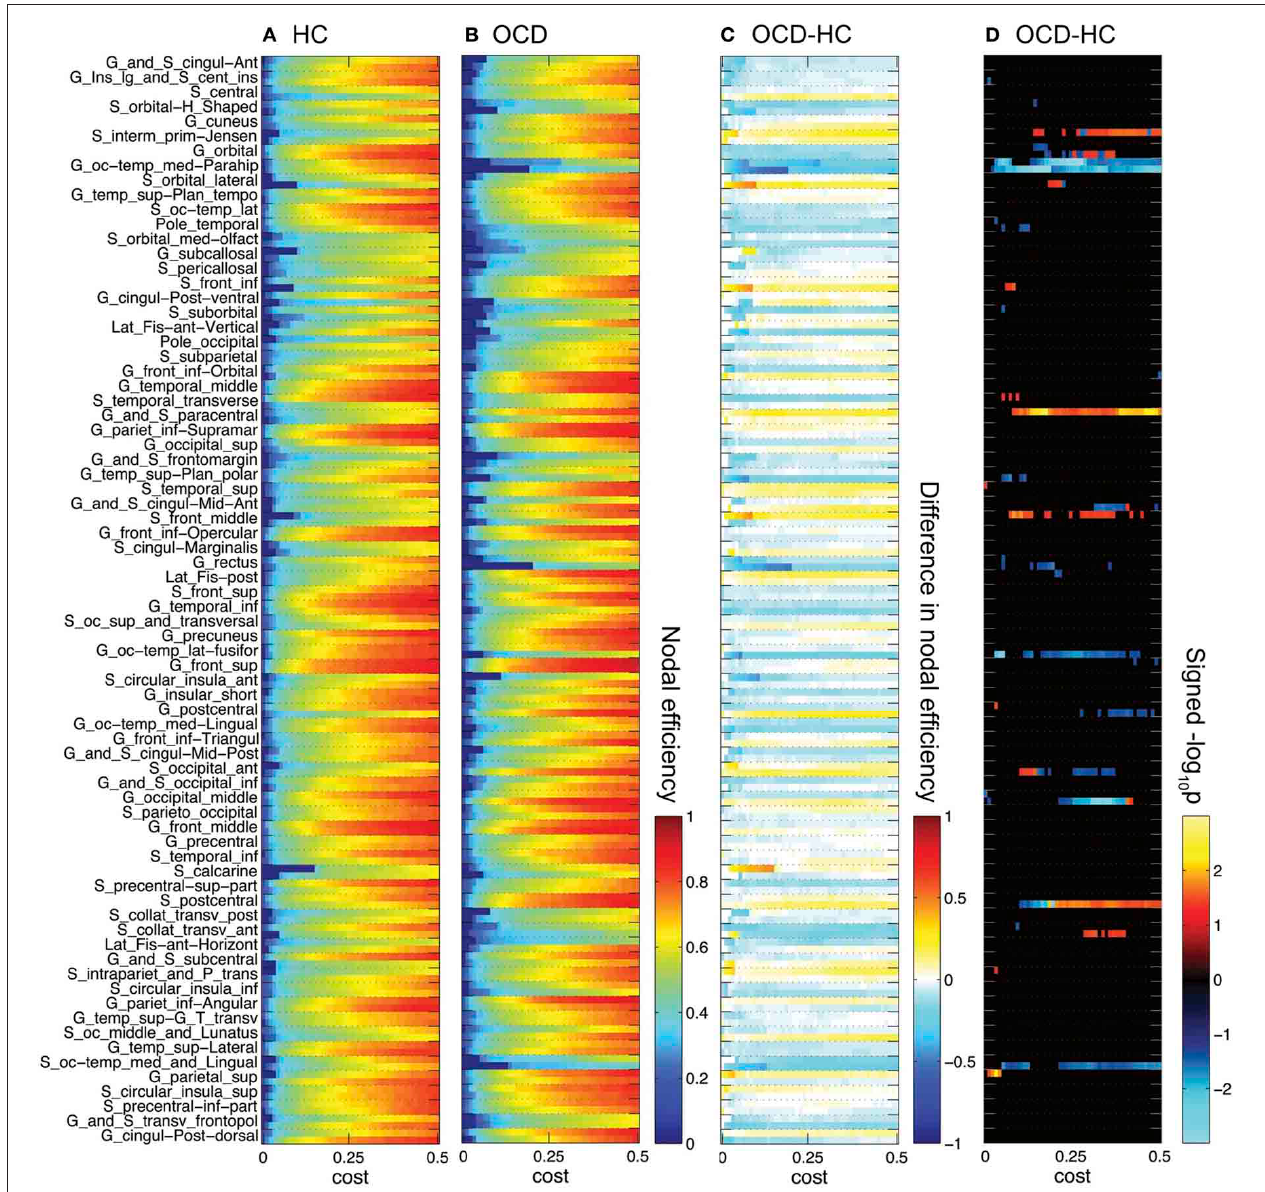
FIGURE 3 | Nodal efficiencies for 148 ROIs are plotted over cost for the controls (HC, A) and the OCD patients (OCD, B). Along the Y-axis, 74 ROI labels are indicated for each set of two rows separated by dashed horizontal lines (upper row for the left hemisphere; lower row for the right hemisphere). See Destrieux et al. (2010) for abbreviation of the ROI labels. The group